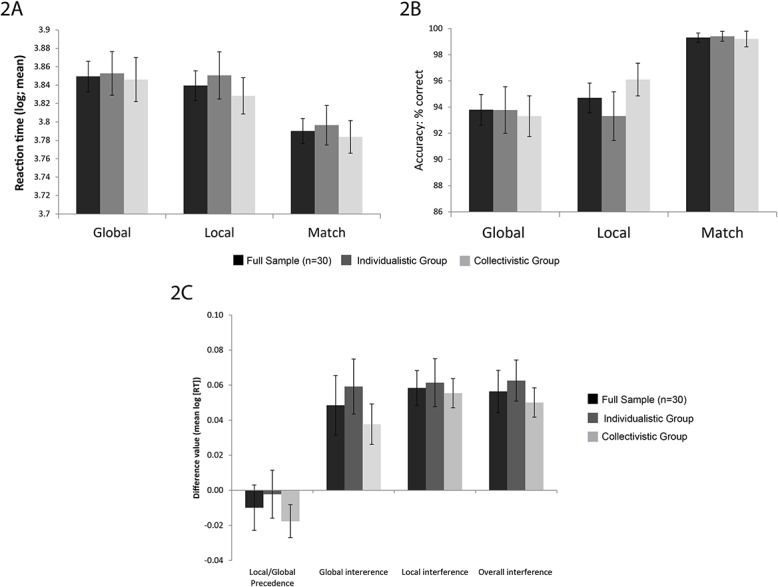
Behavioural data for individualistic and collectivistic groups.2A: Mean reaction time (log) for global, local, match trials; 2B: Accuracy (% correct) for global, local and match trials. 2C: Precedence and interference indices based on reaction time. Also included is data for the whole sample. Error bars are standard error.